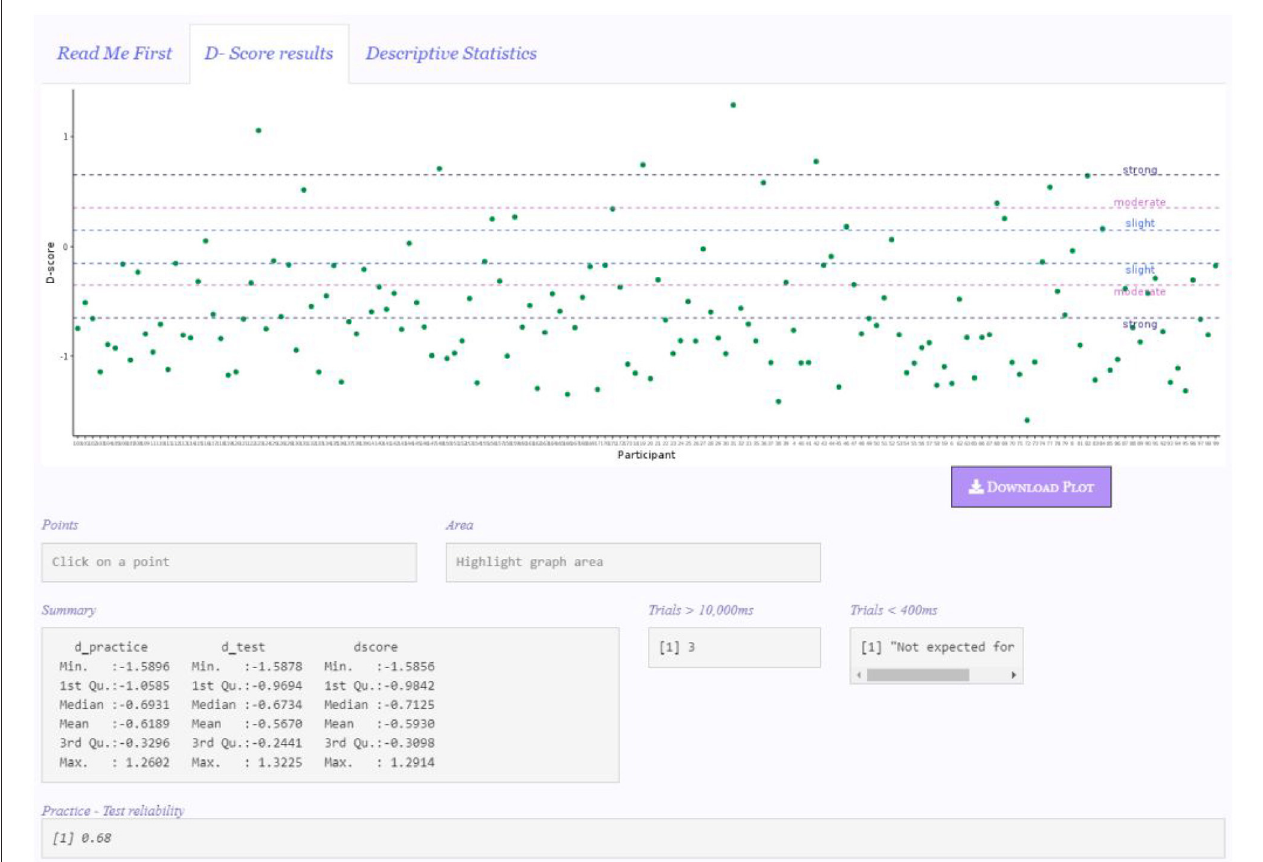
FIGURE 2 | Results